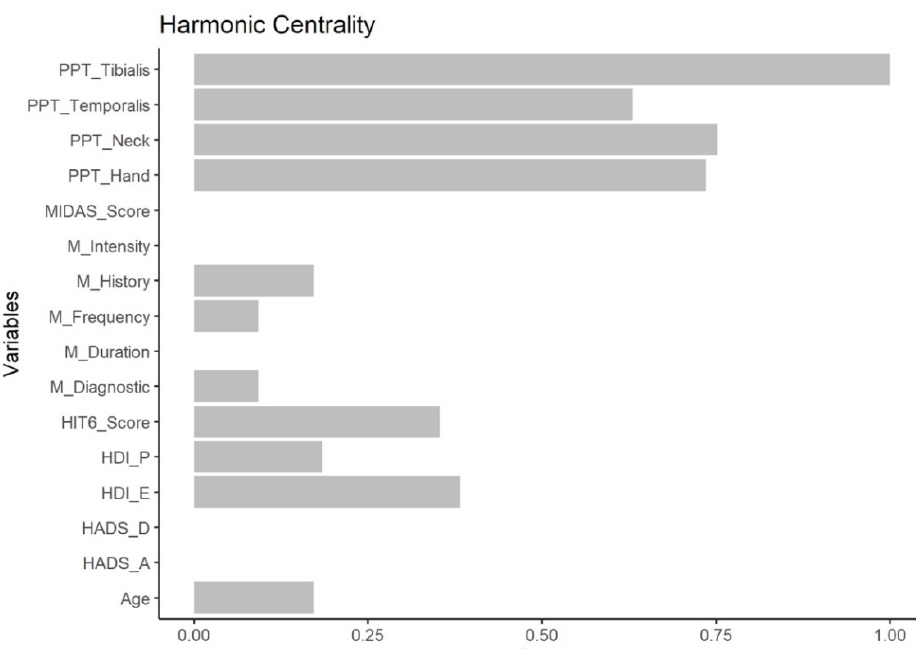
Figure 3. Harmonic Centrality measure (1: maximal importance; 0: no importance) of each node in the network.